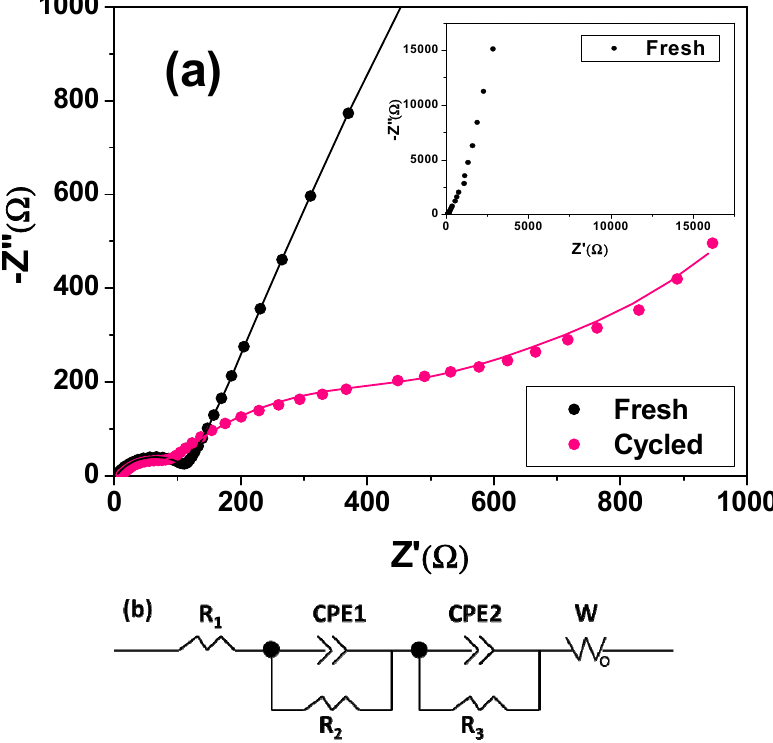
Figure 6. ( a ) Enlarged Nyquist plot of the fresh Co 3 O 4 nanorod electrode at high frequency and Nyquist plot of the cycled electrode in the whole frequency region; the dot and the line are related to the experimental and fitting results, respectively; the inset is the Nyquist plot of the fresh electrode in the whole frequency region. ( b ) Equivalent circuit for the fresh and cycled electrodes; R 1 represents the solution resistance ( R s ) for both electrodes; R 2 is the contact resistance ( R c ) for the fresh electrode or the resistance caused by the SEI layer ( R SEI ) for the cycled electrode; R 3 corresponds to the Li + charge-transfer resistance ( R ct ); CPE1 and CPE2 are constant phase elements; W represents the Warburg